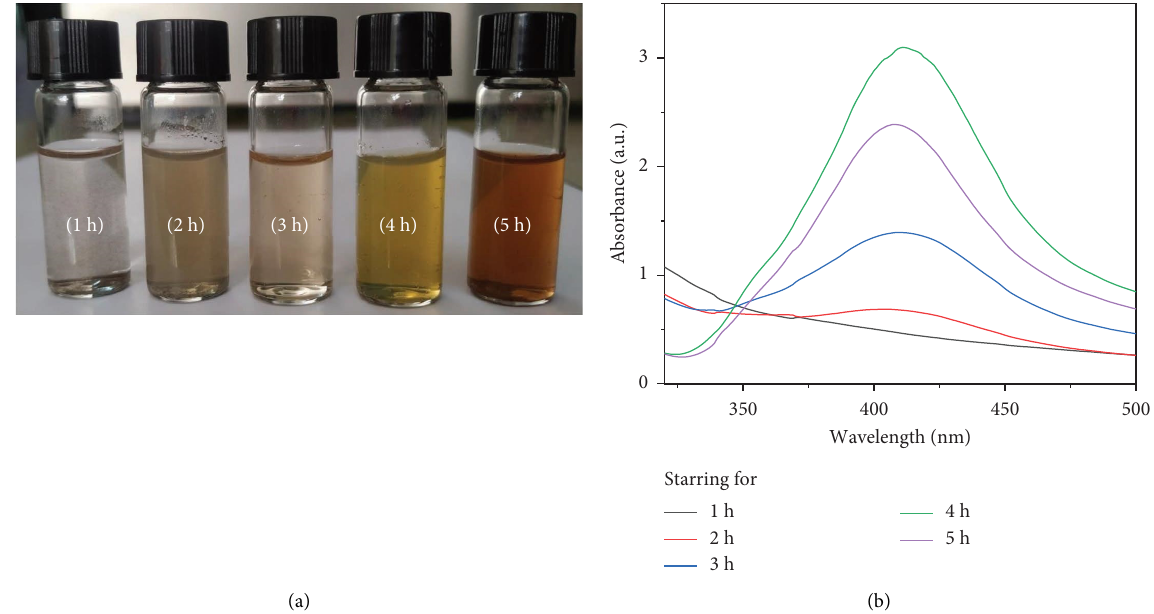
Figure 3: Color shift of synthesized Ag-NPs at diferent reduction time: (a) at 1–5h and (b) the corresponding UV-Vis data.